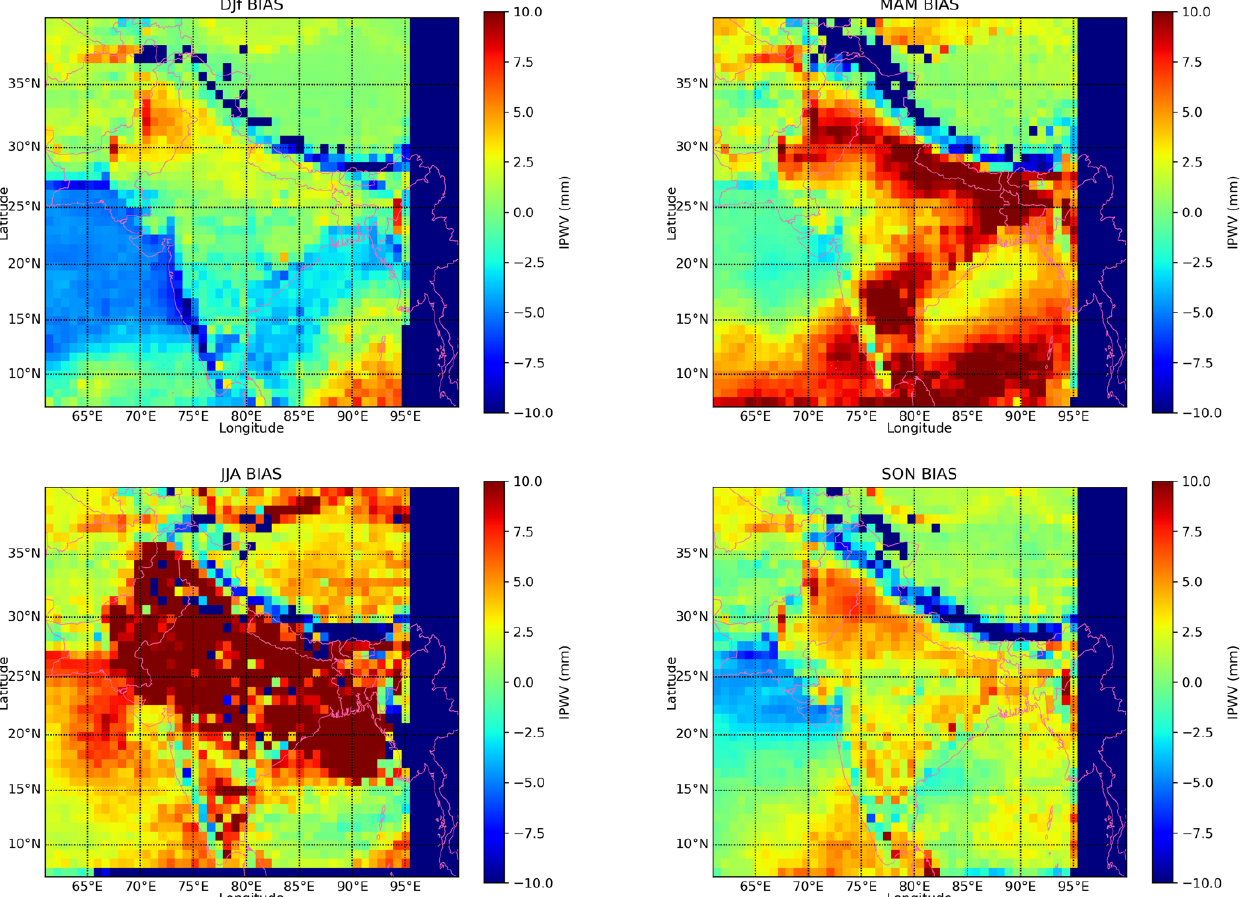
Figure 7. Seasonal bias of IPWV between CAMS and